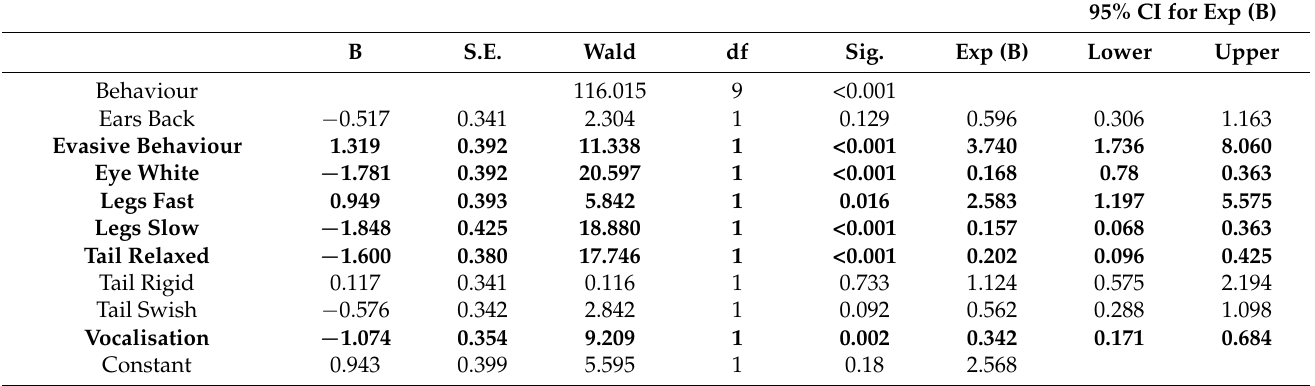
Table 5. Summary of the binary logistic regression analysis, which includes the behaviours of calves ( n = 15) at two rodeos, with increased and behaviours with a decreased risk of status “1” (behaviour present) occurring. Statistically significant ( p < 0.05) associations are highlighted in